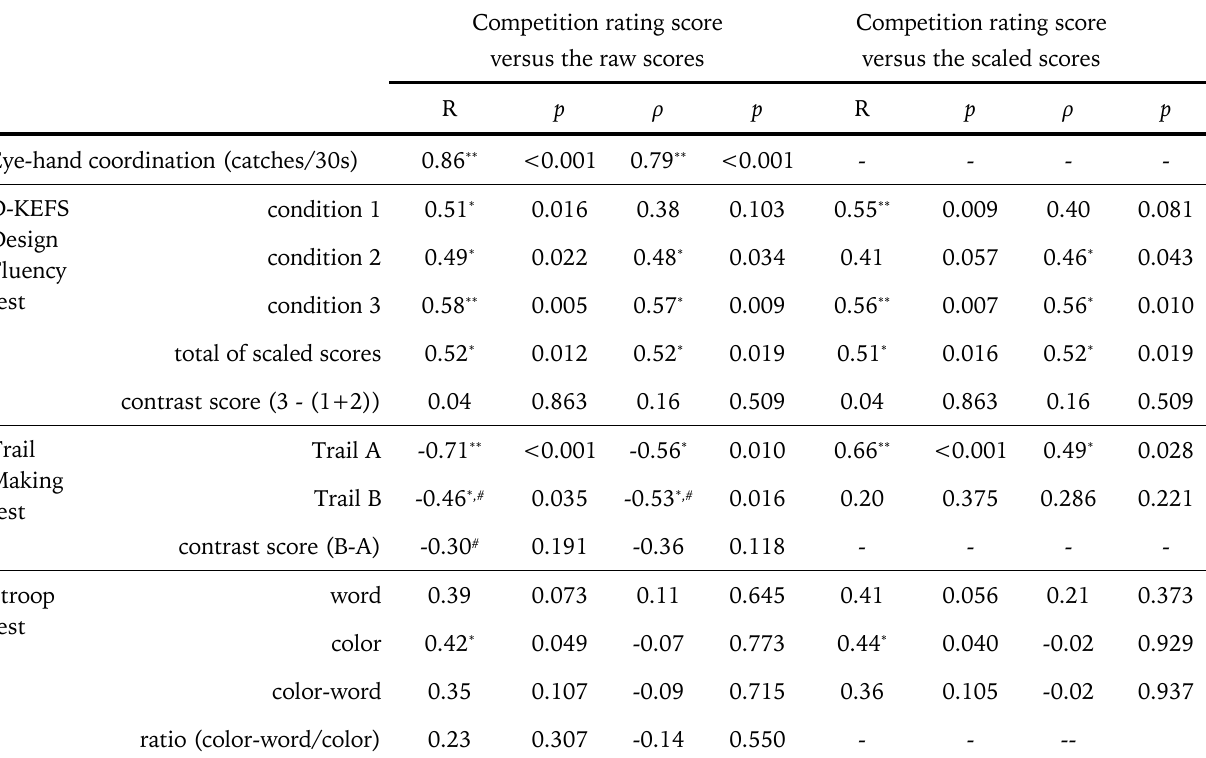
Table 3. Association between eye-hand coordination and executive functions assessments outcomes and table tennis performance in para table tennis players